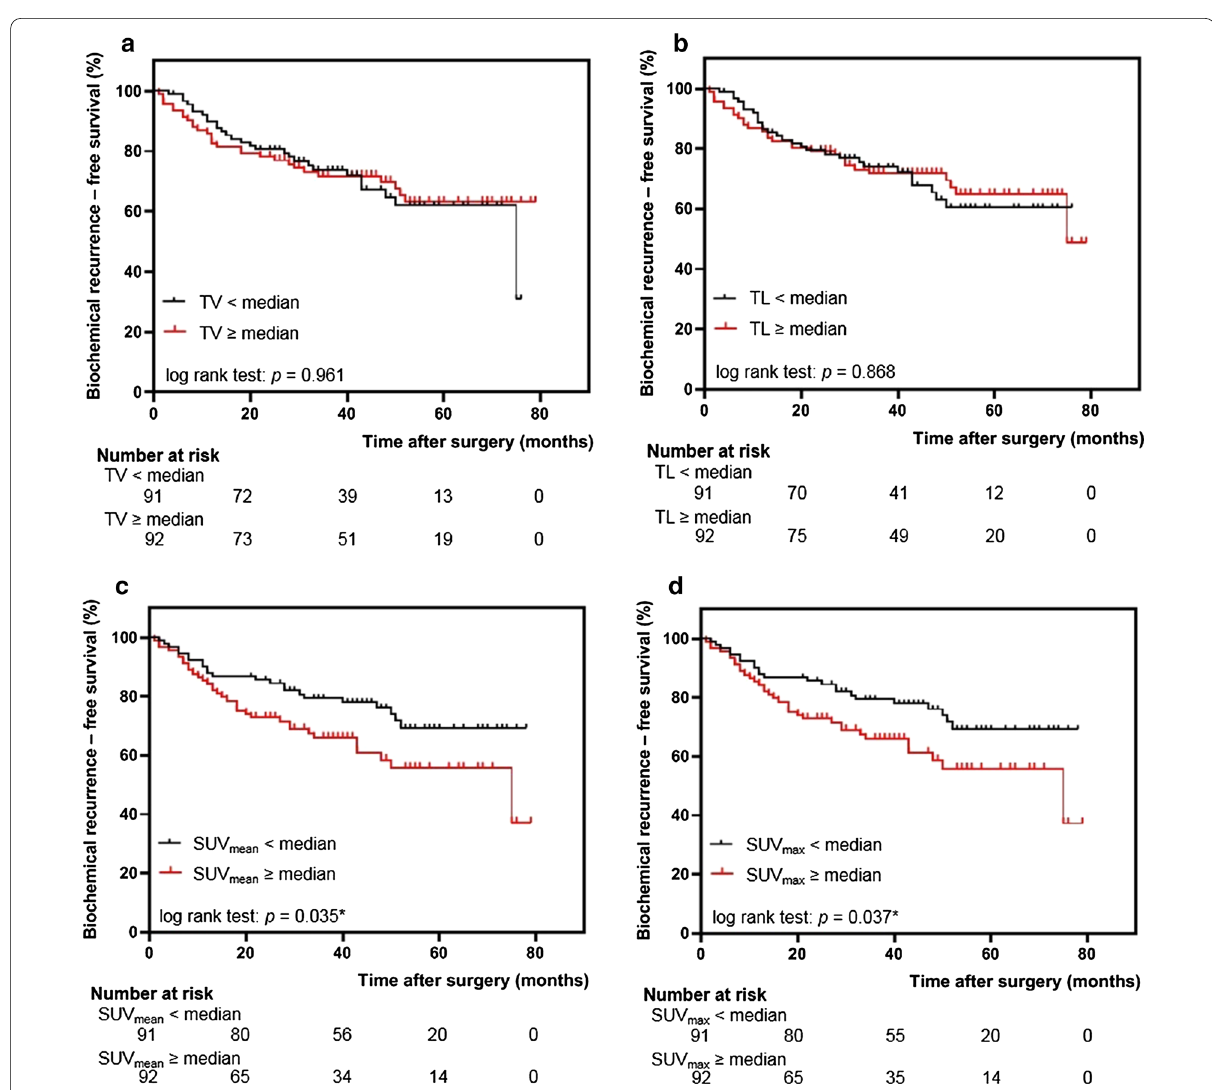
Fig. 3 Kaplan–Meier curves comparing biochemical recurrence‑free survival of selected patients stratified by a tumor volume, b total lesion, c SUV mean and d SUV max . Longer biochemical recurrence‑free survival was associated with lower SUV mean and SUV